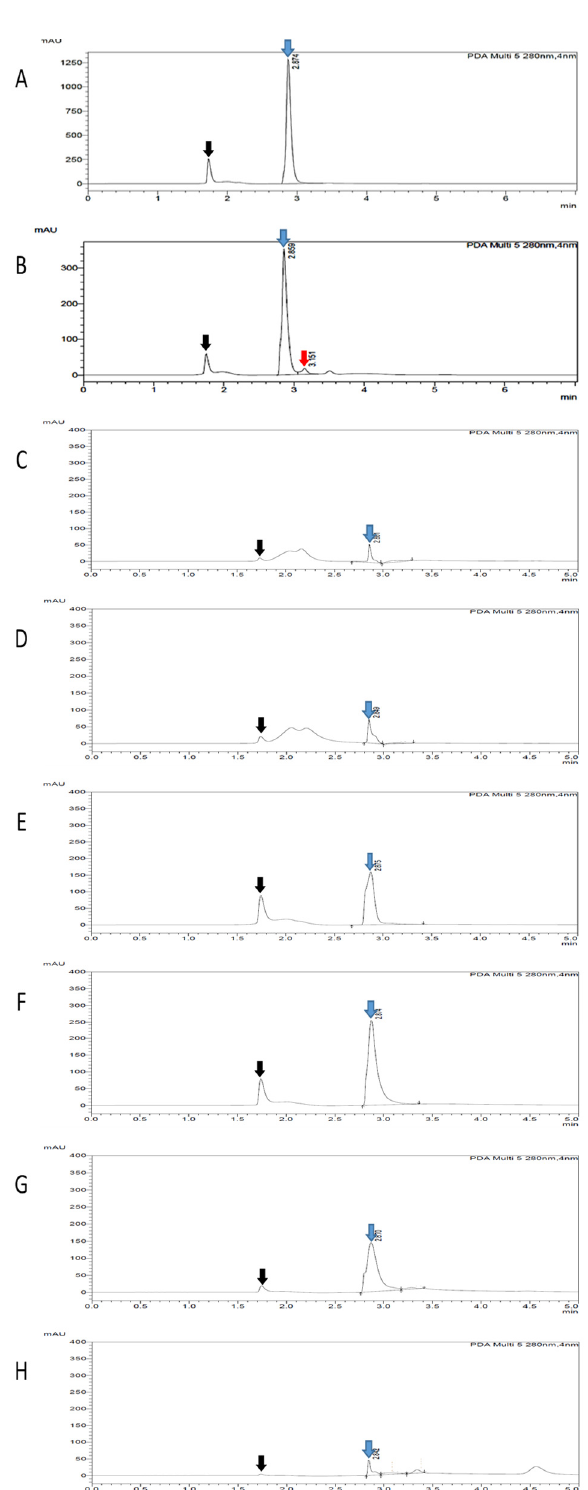
Figure 3. High-performance liquid chromatography (HPLC) analysis to detect and quantify the gallotannin compound. ( A ) Synthetic pure gallotannin (positive control), ( B ) QI crude aqueous extract, ( C ) F1, ( D ) F2, ( E ) F3, ( F ) F4, ( G ) F5 and ( H ) F6. Blue arrows indicate that gallotannin compounds were detected at a retention time of ~2.874 min. Red arrow indicates an extra unknown compound detected at a retention time of ~3.151 min in the QI crude extract only. Black arrows indicate that a prominent peak appeared before the gallotannin due to the oxidation of samples during processing of samples.